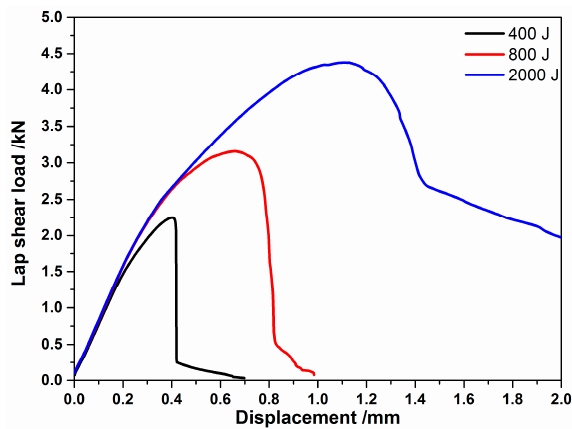
Figure 9. The lap shear load–displacement curves recorded for various welding energies.